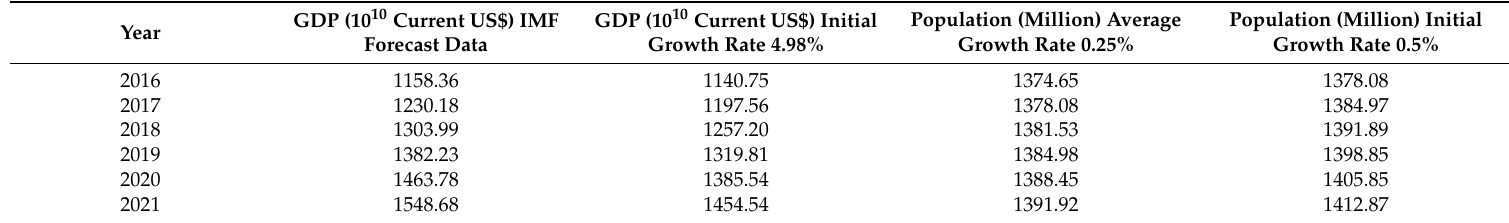
Table 4. Chinese GDP and population estimation (2016–2021).